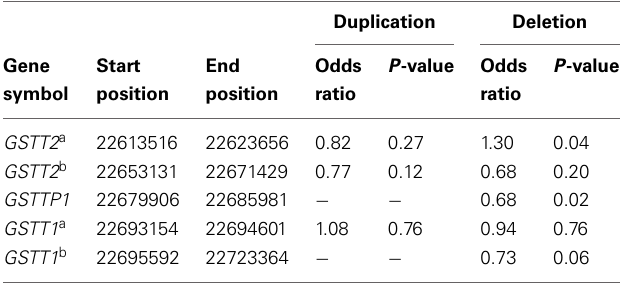
Table 5 | Association of CNVs in the region from GSTT1/GSTT2 region with smoking ∧